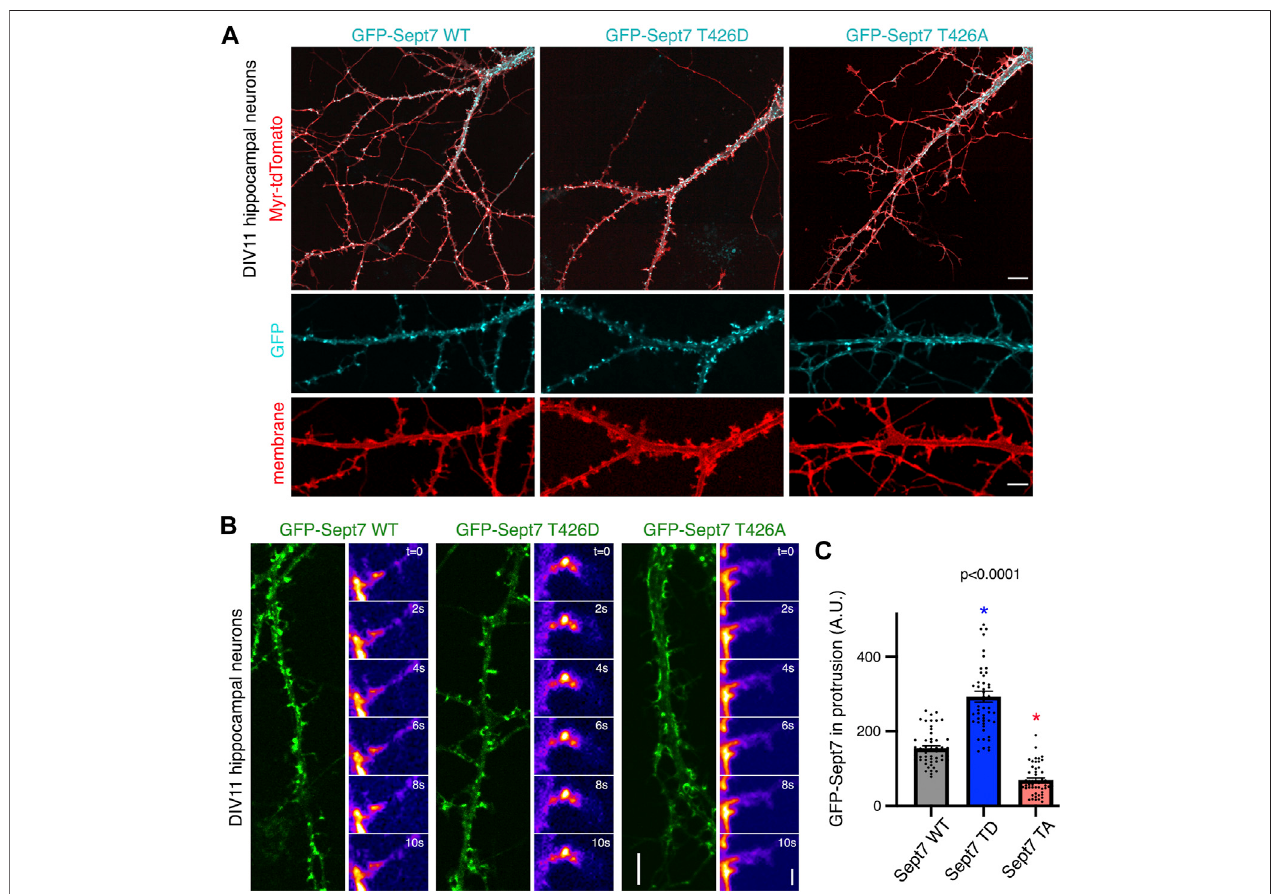
FIGURE 2 | Phosphorylation of Sept7 alters its localization and dynamics. (A) Hippocampal neurons were transfected with GFP-tagged Sept7-WT, phosphomimetic Sept7-T426D, or phosphomutant Sept7-T426A along with membrane marker myristoylated-tdTomato at DIV9 and then fi xed at DIV11. Phosphomimetic GFP-Sept7 (T426D) expression leads to early maturation of dendritic spines compared to Sept7-WT, while phosphomutant Sept7-T426A expressing neurons exhibited only fi lopodial protrusions. (B) Montage of time lapse images showing DIV11 hippocampal neurons transfected at DIV9 with GFP-tagged wild- type Sept7-WT, phosphomimetic Sept7-T426D, or phosphomutant Sept7-T426A. Phosphomimetic Sept7-T426D is stably localized within the dendritic spine head, phosphomutantSept7-T426Alocalizestothebaseofthedendriticspine,whereasthewild-typeSept7-WTshowsdynamicchangesinitslocalizationwithinprotrusions. Scale bar represents 5 µm (green) and 1 µm (montage), respectively. (C) Quanti fi cation of GFP intensity in protrusions of DIV11 neurons transfected with GFP-tagged wild-type Sept7-WT, phosphomimetic Sept7-T426D, and phosphomutant Sept7-T426A. Values represent mean intensity, error bars represent SEM and n = 50 protrusions from 10 neurons in each condition. Dunnett ’ s multiple comparison test, p < 0.0001.